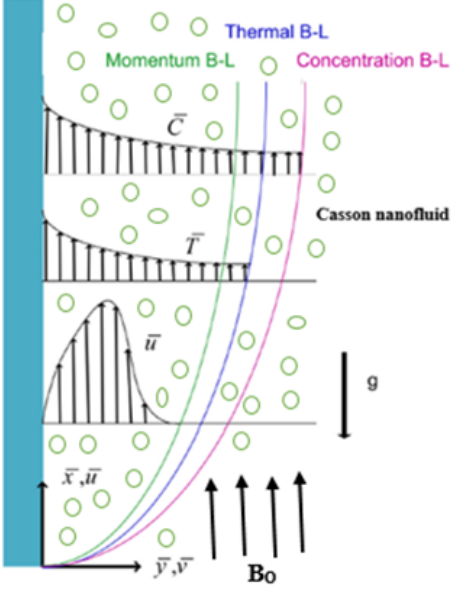
Figure 1. Velocity, temperature and concentration profiles in free convection flow of a Casson fluid over a vertical